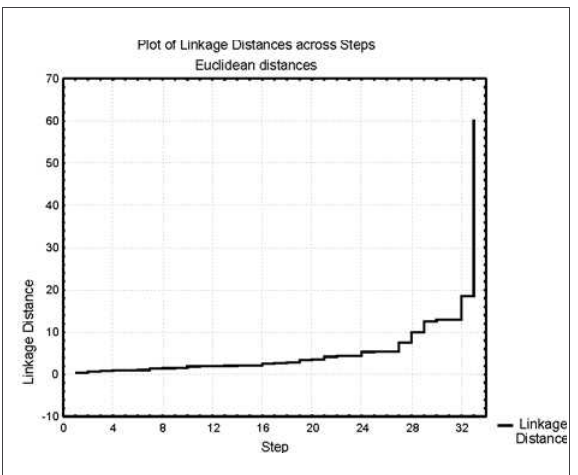
Fig 5. Hierarchical cluster anglysis – a linear graph of linkage distances at clustering steps